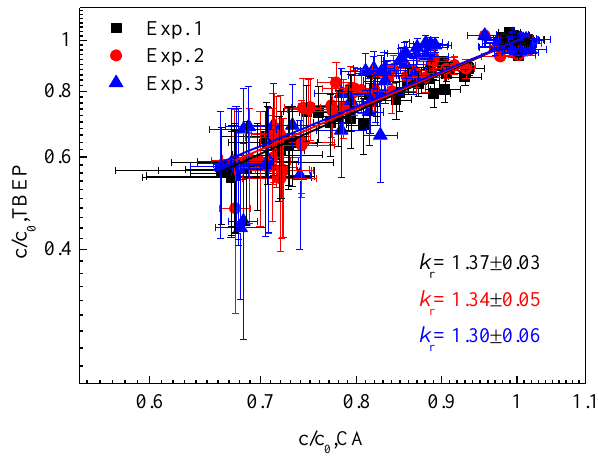
Figure 5. Relative rates for externally mixed CA and TBEP-AN at 298K and (30 ± 3)% RH.